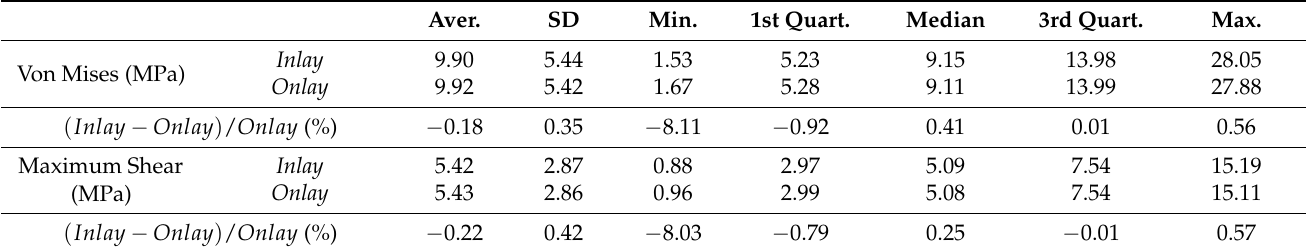
Table 9. Statistical description of the stress distributions for the “bed” geometry at the dentin of both restorations. Aver. SD Min. 1st Quart.